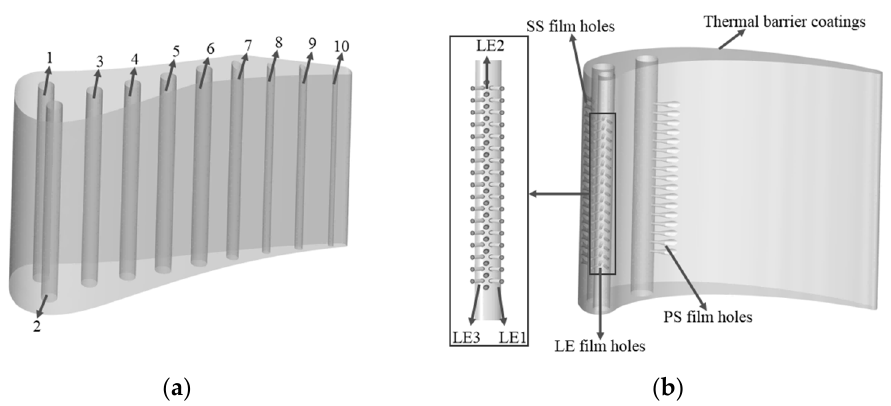
Figure 1. Stator vane and rotor blade. ( a ) C3X vane; ( b ) VKI blade. Table 1. Geometric characteristics of cooling channels.